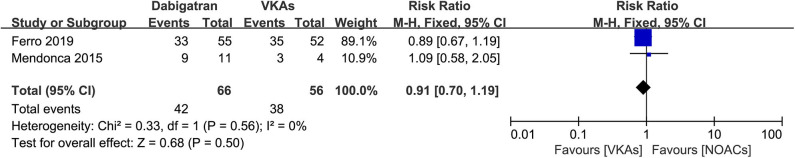
Recanalization between dabigatran and VKAs.